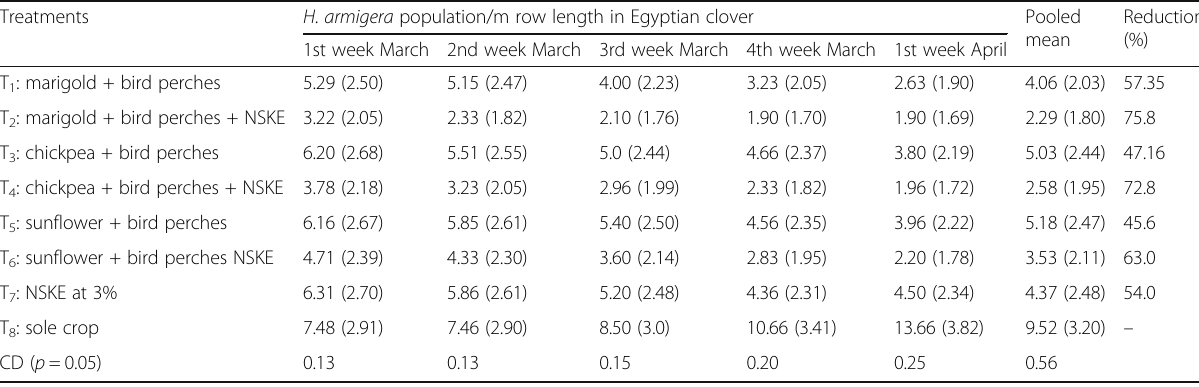
Table 1 Larval population of H . armigera in different treatment combinations in berseem during vegetative growth stage